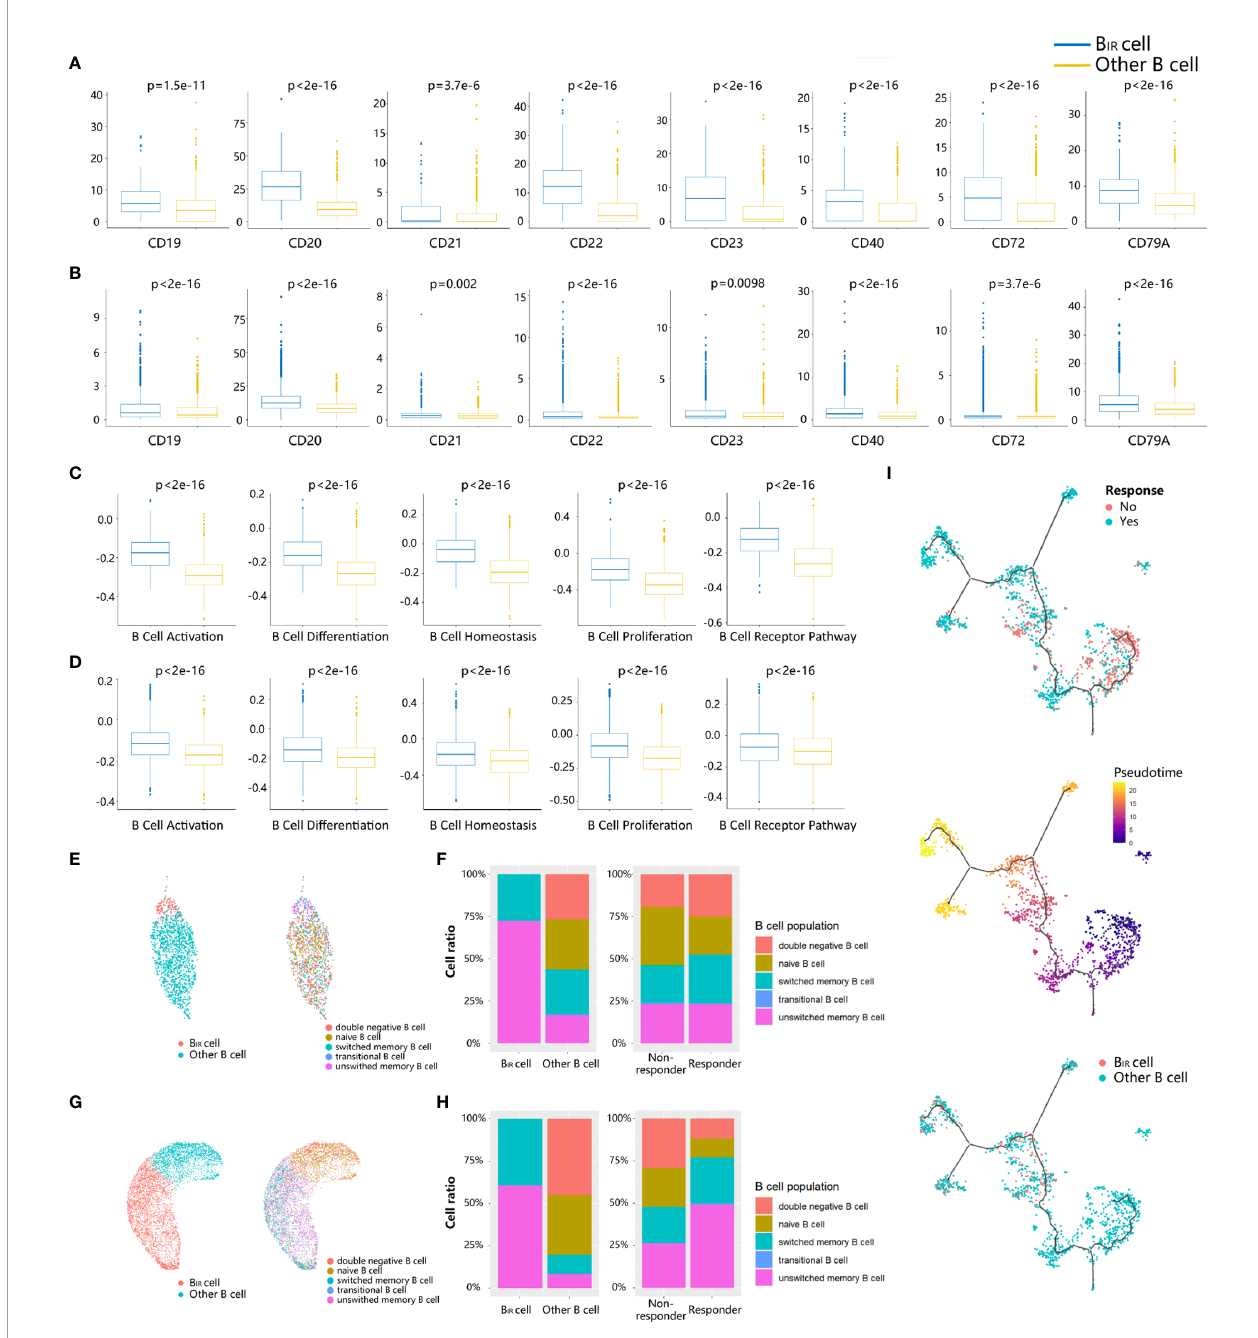
FIGURE 2 | Phenotypes of B IR cells. (A, B) Bar graphs show that seven B cell marker genes (CD19,CD20, CD21, CD22,CD23, CD40, CD72,CD79A) are more signi fi cantly. (p <0.05) upregulated in B IR cells than in other B cells from pro fi les GSE120575 (A) and GSE123813 (B) . scRNA-sequencing data are normal ized as transcripts per million (TPM). The expression is displayed as the log2(TPM+1) of each cell from two clusters. (C, D) Bar graphs show that fi ve B cell-related gene sets (activation, differentiation, homeostasis,proliferation, BCR pathway) are more signi fi cantly (p <0.05) enriched by B IR cells than by other B cell populations from pro fi les GSE120575 (C) and GSE123813 (D) . The enrichment is displayed as the gene set variation analysis (GSVA) scores of each cell from two clusters. (E, G) UMAP plots of B cells in the tumors of patients treated with ICI from two scRNA-seq datasets GSE120575 (E) and GSE123813 (G) . Cells are colored based on two B cell populations including B IR and other B cells (left) and fi ve B cell subpopulations de fi ned by biomarkers (right). (F, H) Histogram offrequency of B cell subpopulations from pro fi les GSE120575 (F) and GSE123813 (H) . Cells are grouped based on B cell populations including B IR and other B cells (left) and patients' response to ICI therapy (right). (I) Trajectory analysis for the B cells.B cells from GSE120575 are reclustered and visualized by UMAP plots. The solid black line indicates the main diameter path of UMAP and provides the backbone of Monocle's pseudotime ordering of the cells, indicating B cell differential states. Each dot represents an individual cell colored by patients' response to ICI therapy (up), by pseudotime (middle) or by cluster